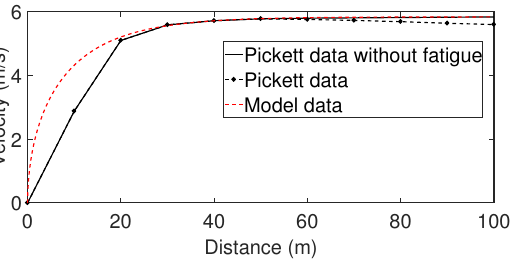
Figure 10. Velocity versus distance curves, where Pickett et al. [25] field data can be compared with those obtained by the model. See text for details.